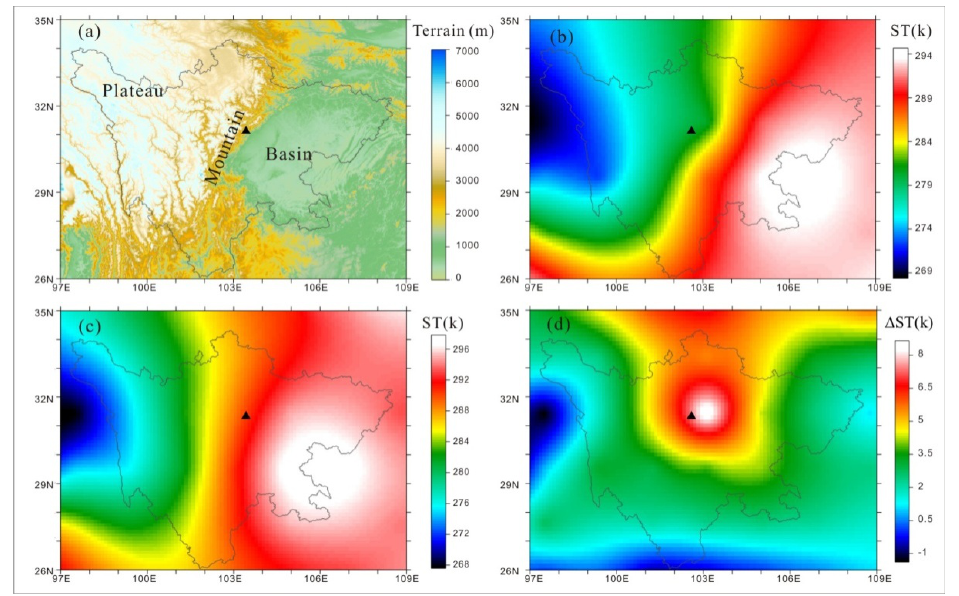
Figure 1. ( a ) Spatial distribution of regional terrain. ( b ) Spatial distribution of 33 years (1979–2012, excluding 2008) mean of skin temperature (ST) on 6 May. ( c ) Spatial distribution of skin temperature (ST) on 6 May 2008. ( d ) Spatial distribution of differential skin temperature ( ∆ ST) on 6 May 2008, obtained by subtracting (b), representing a terrain background, from